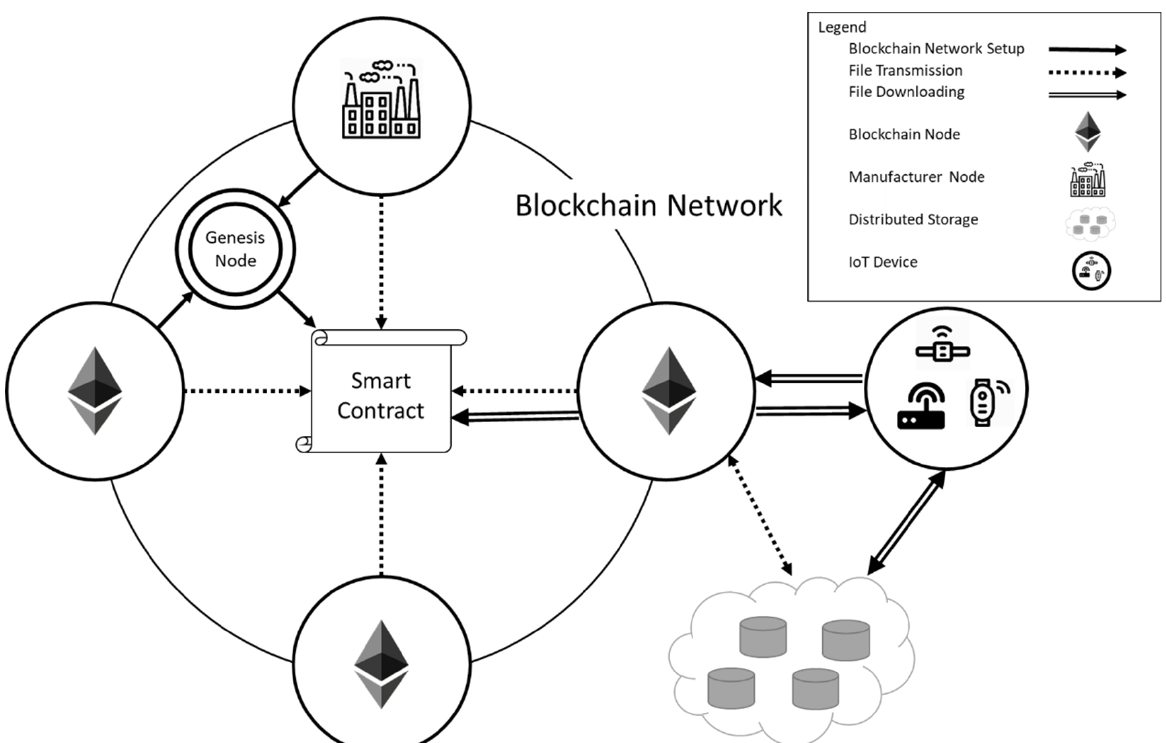
Figure 1. System architecture of the proposed firmware update platform.